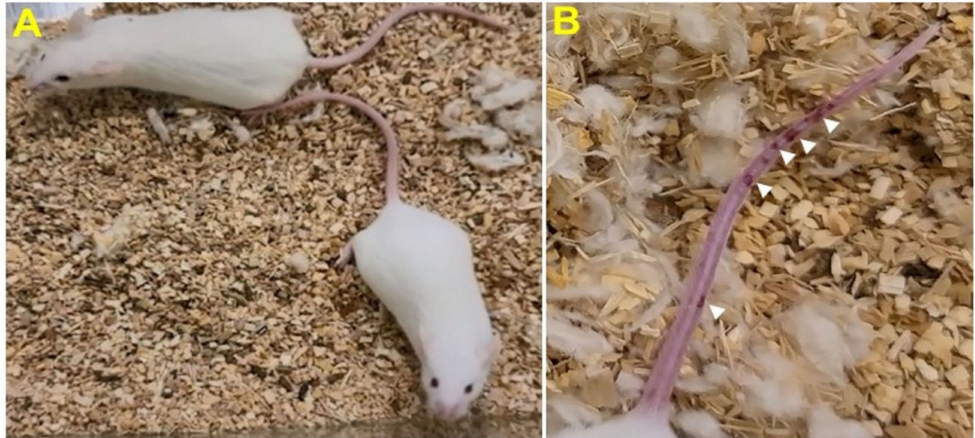
Figure 3. MHV-1 inoculated mice displayed severe disease. ( A ) Normal mouse. ( B ) A representative mouse from the MHV-1 inoculated group showing venous thrombosis consistent with symptoms in patients with COVID-19 ( n = 11).